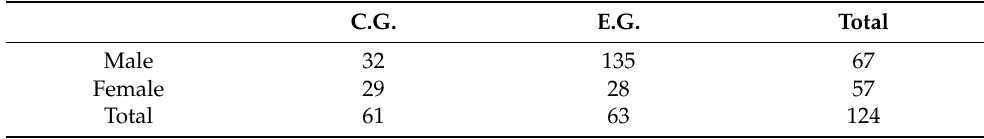
Table 1. Gender of each Group.